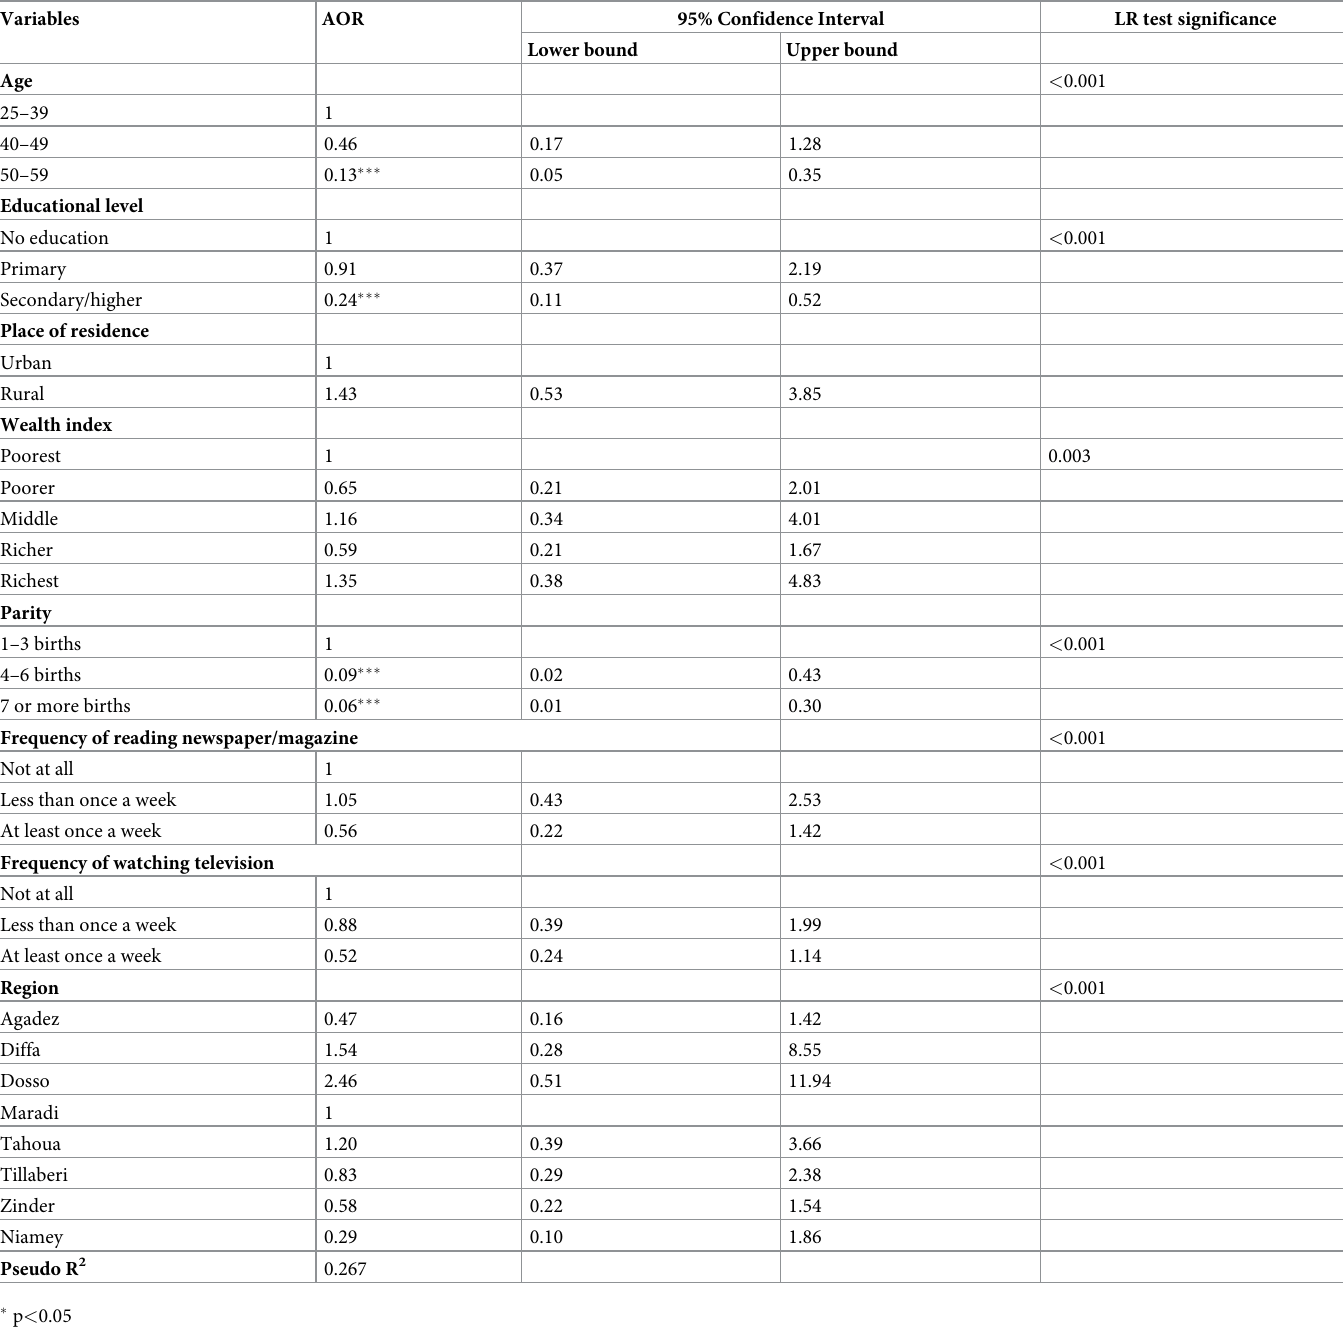
Table 4. Binary logistic regression analysis on predictors of wanting more children among men in